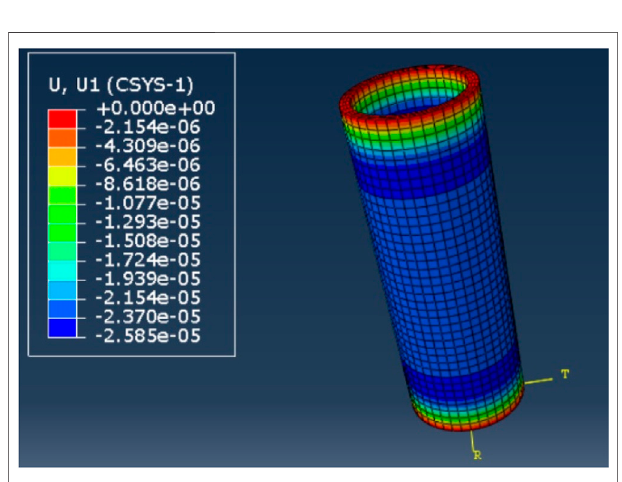
FIGURE 6 | Calculation results of the casing